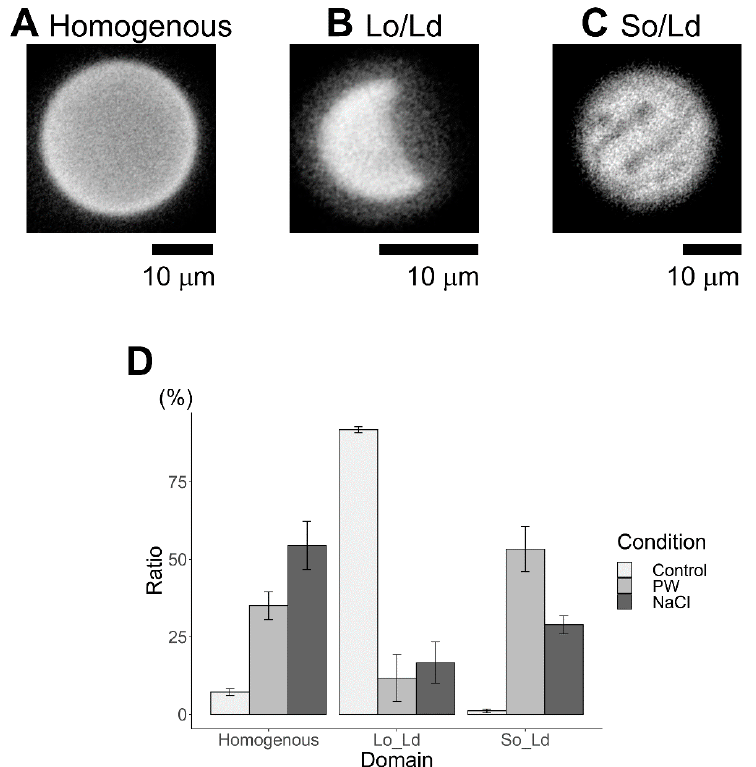
Figure 5. Representative microscopic images of multicomponent liposomes made with ergosterol as the sterol component, featuring three different phase-separated lipid domains ( A , B ), and percentages of phase-separated structures ( D ). ( A ) Homogenous (DPPG:DPPC:DOPC:Erg), 15:25:40:20 made in pure water (PW); (B) Lo/Ld (DPPC:DOPC:Erg), 40:40:20 made in pure water (Control), and